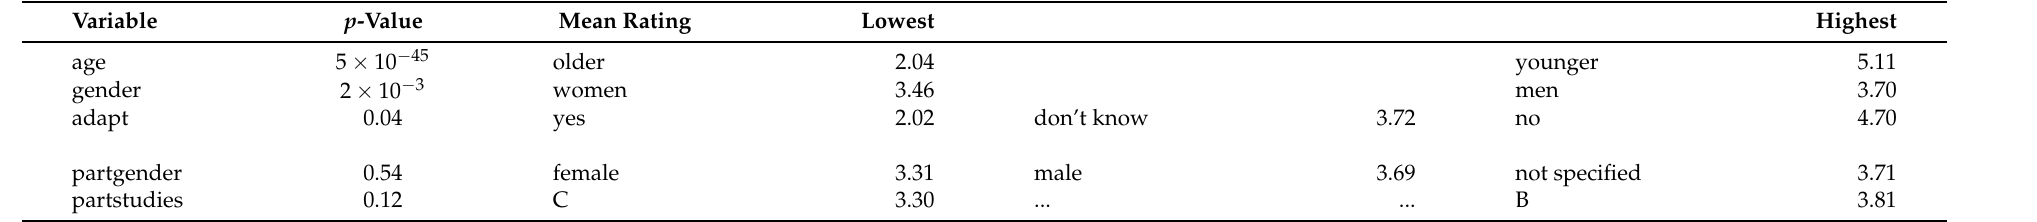
Table A6. Expertise with Laptop computer (LT), p -value from ANOVA with associated mean